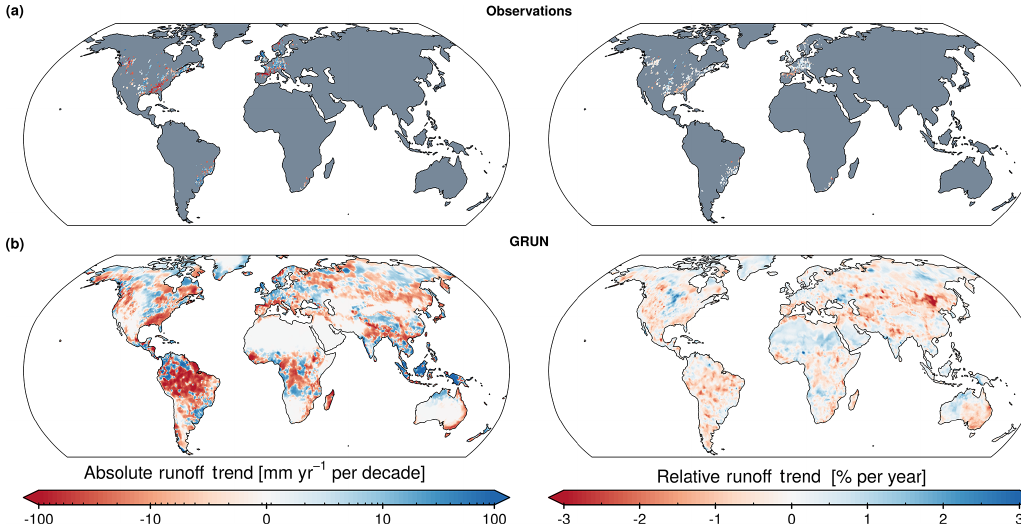
Figure 10. Changes in annual runoff rates (1971–2010) expressed in absolute terms (left) and percentage change relative to long-term mean (right). (a) Observed trends. (b) Trends based on GRUN.